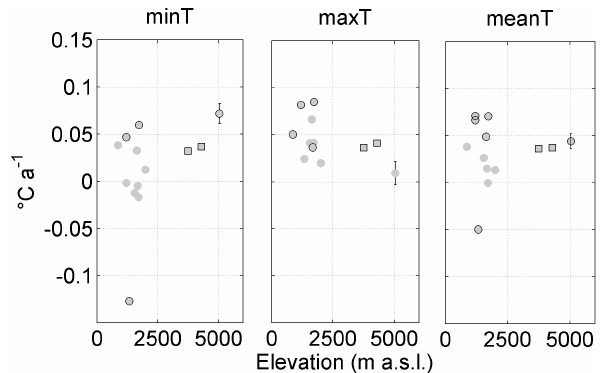
Figure 7. Elevation dependency of minimum (a) , maximum (b) , and mean (c) air temperatures with the Sen’s slopes for the 1994– 2013 period. The circle indicates stations with less than 10% of missing daily data, and the star indicates stations showing a trend with p -value < 0.1. The red marker represents the trend and the as- sociated uncertainty (2 standard deviations) referred to the recon- structed time series for the AWS1 station (PYRAMID). Data are reported in Table